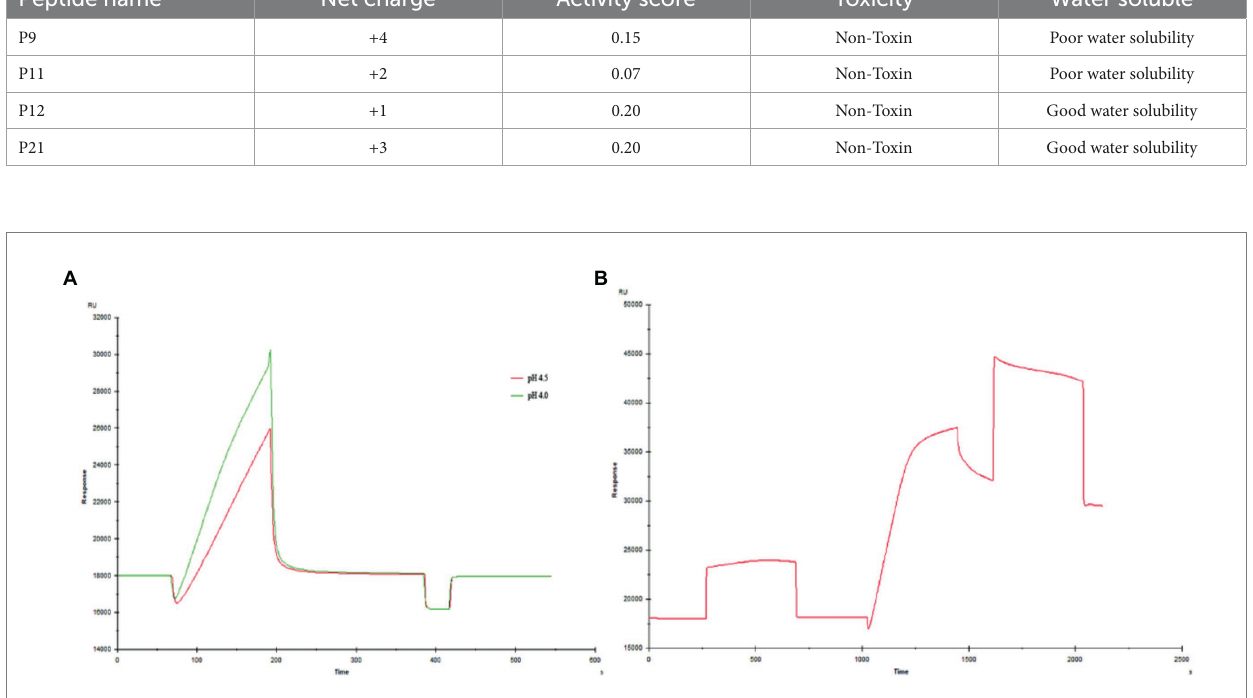
FIGURE 1 Coupling of A β 1–42 and CM-5 chip (A) Exploration of pH conditions (B) Coupling